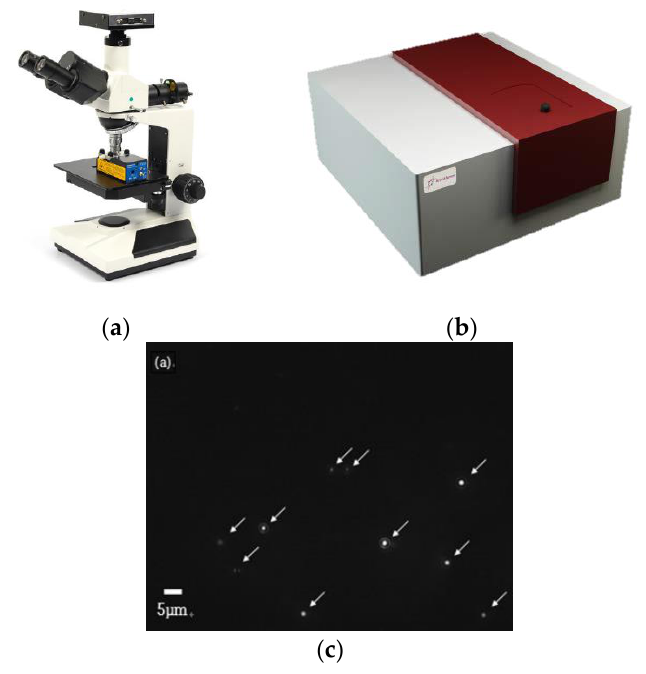
Figure 2. Nanobubble ( a ) NTA Instrument (Malvern Nanosight LM10, Malvern Panalytical Ltd, Unites Kingdom), ( b ) image of nanobubbles [17], and ( c ) Zeta Potential Analyzer (ZetaPALS).